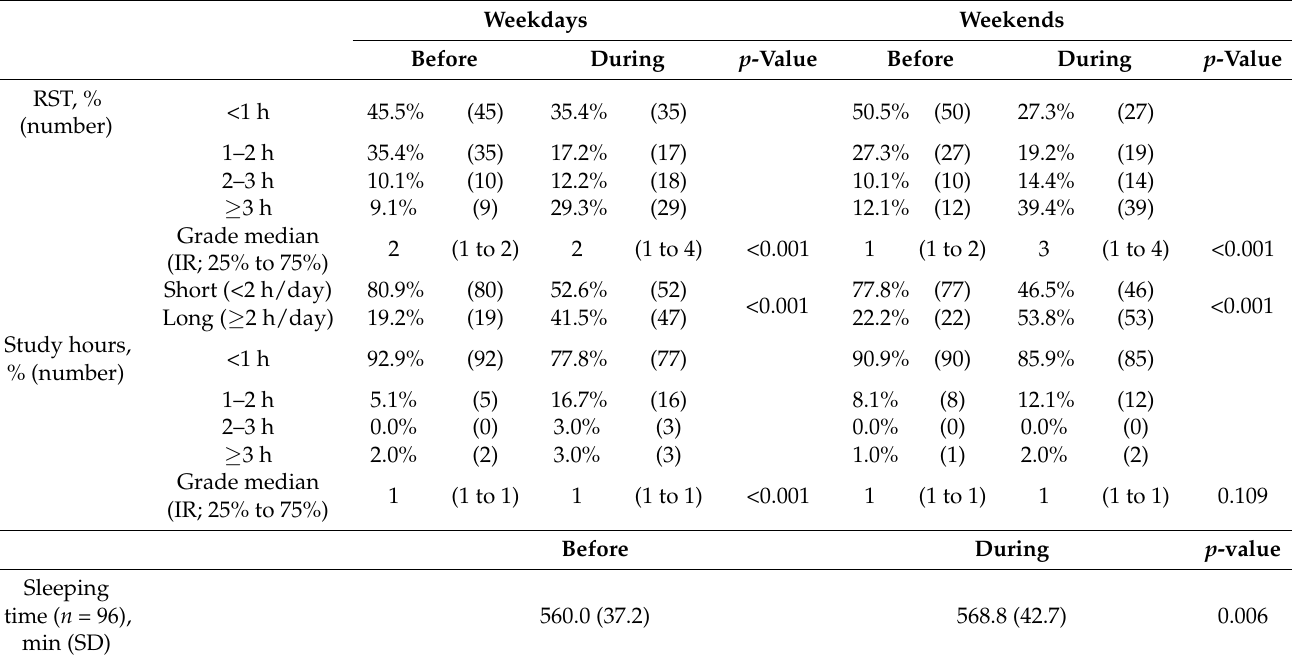
Table 1. RST and study hour changes at home on weekdays and weekends ( n = 99).